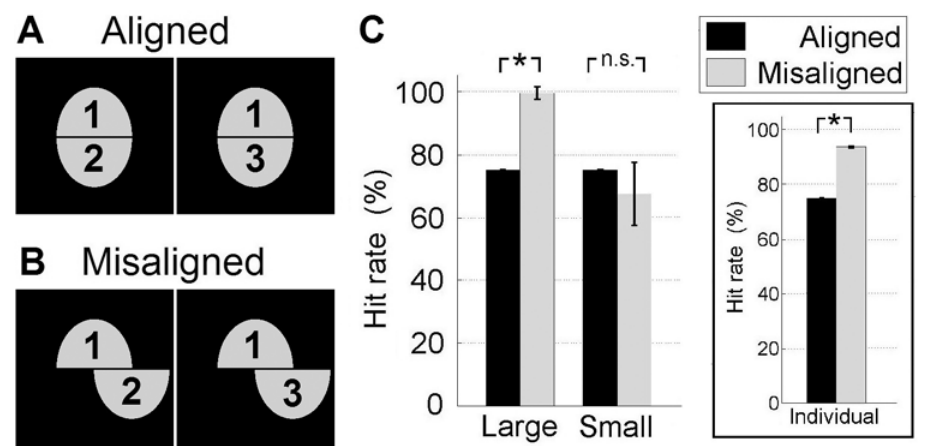
Fig 1. Tuning size accounts for the Composite Face Effect (CFE). (A) Schematic for aligned composite faces in “ same ” trials. Top halves are identical, while bottom halves are different. People sometimes incorrectly perceive the two identical top halves as different. (B) Schematic for misaligned composite faces. Human judgement of the top halves (as being identical) is significantly more accurate for misaligned than aligned composites. (C) The CFE is produced by C2 model neurons with large – but not small – tuning size. (Inset) Each individual C2 model neuron with large tuning size can produce the CFE by itself. Error bars: